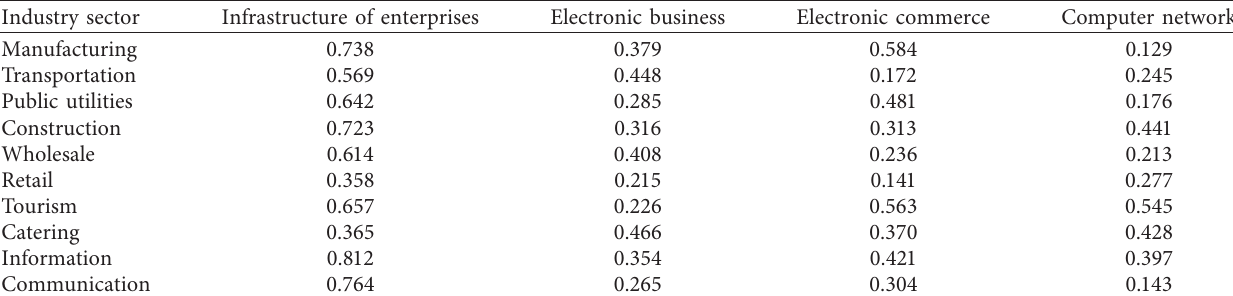
Table 2: Industry sector proportions of digital economy in smart city